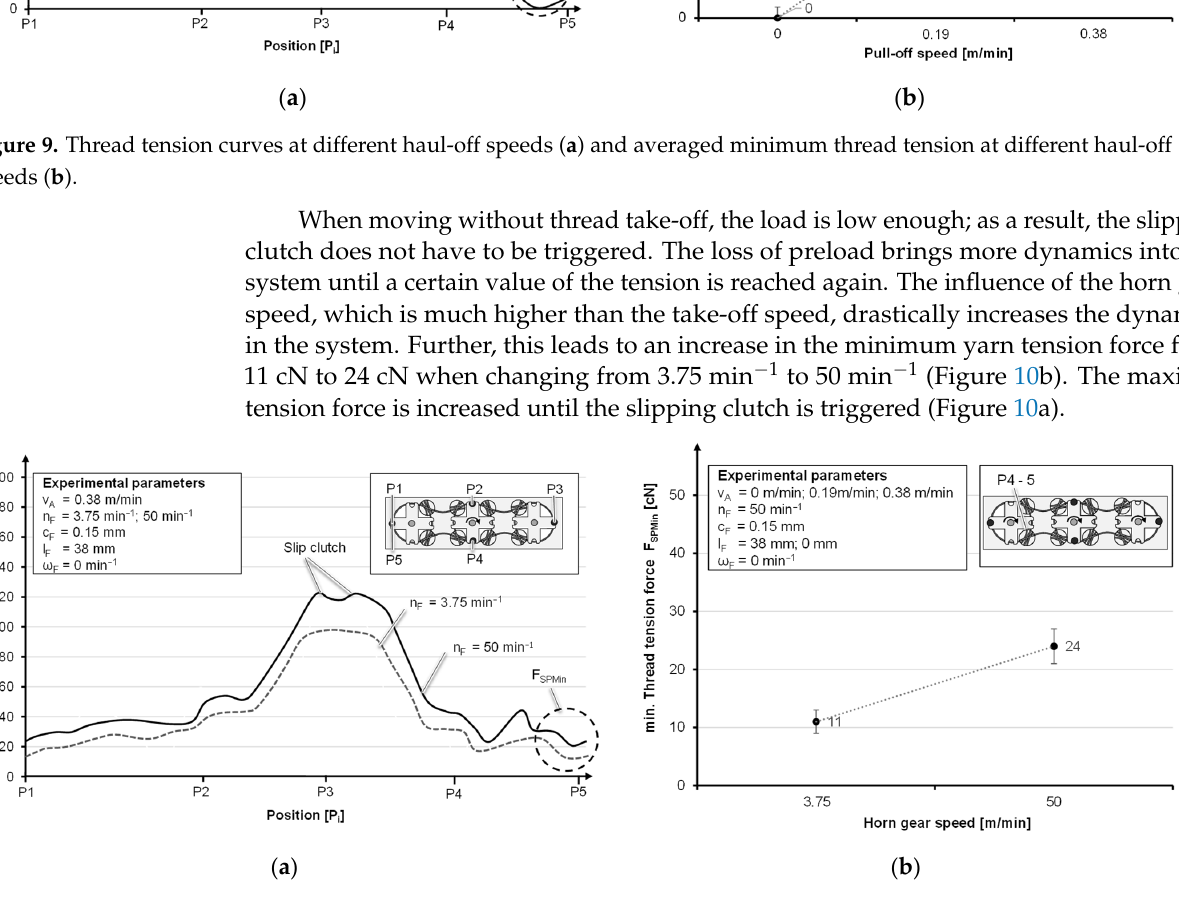
Figure 10. Thread tension force curves at different horn gear speeds ( a ) and averaged minimum thread tension force at different horn gear speeds ( b ).